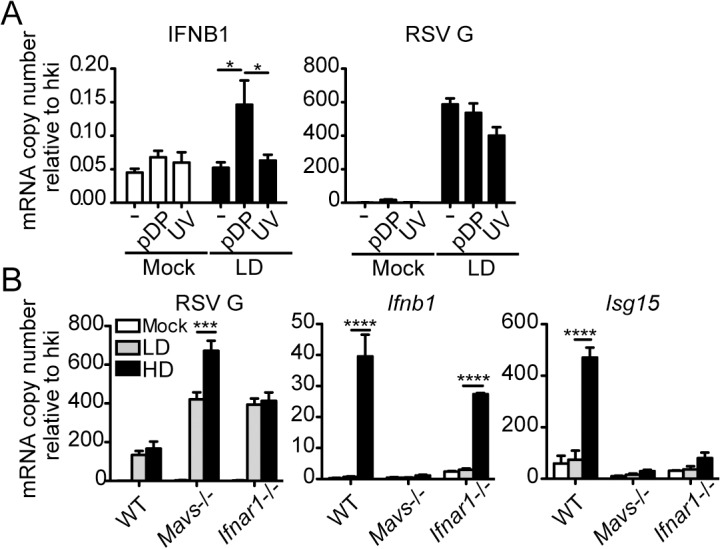
RSV iDVGs promote a MAVS-mediated antiviral response during RSV infection.(A) Expression of RSV G and antiviral genes in HEp2 cells infected for 10 h with RSV-LD at a moi of 1 TCID50/cell alone or in the presence of 20 pg/cell of purified defective particles (pDP) or UV-inactivated pDPs (UV). (B) Expression of RSV G and antiviral genes in wild type, Mavs-/-, or Ifnar1-/- MEFs infected with RSV-LD or HD for 10 h at a moi of 1 TCID50/cell. Gene expression is shown as copy number relative to a house keeping gene expression index (hki) determined from the expression of ACTB (β-actin) and GAPDH (A) or Rps11 and α-tubulin (B). Error bars indicate mean ± SEM of three independent experiments each with triplicate technical measurements (*p<0.05, **p<0.01, ***p<0.001, ****p<0.0001 by two-way ANOVA with Bonferroni post hoc test).